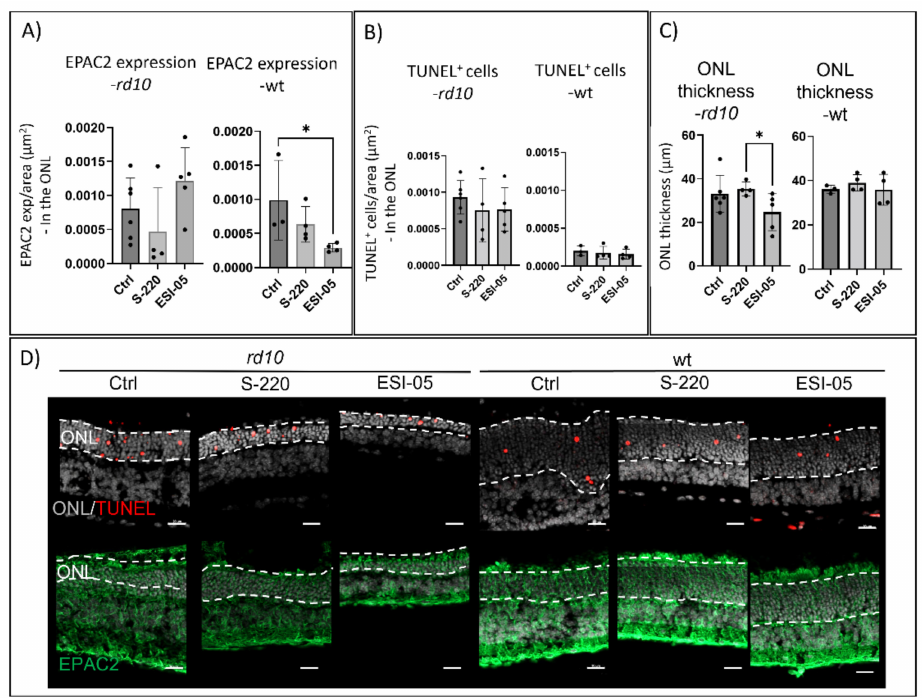
Figure 6. Inhibition of EPAC2 activity decreases ONL thickness in the rd10 model. ( A ) Inhibition of EPAC2 activity by ESI-05 in rd10 explants (treatment paradigm: PN12-PN24) caused a numerical but not significant increase in EPAC2 expression compared to the control (Ctrl, i.e., untreated retina) and the S-220-treated retina. For the wt retina, the activator S-220 reduced EPAC2 expression significantly in the ONL compared to Ctrl. ( B ) The rd10 explants had significantly more TUNEL-positive cells compared to their healthy counterparts. No differences in the number of TUNEL + cells was associated with the treatments. ( C ) ESI-05 treatment leads to a significant reduction in ONL thickness in rd10 explants but not in wt explants. ( D ) Examples of stainings, forming the basis of the graphs above. All figures represent mean ± SD. Results represent three to six biological replicates. The Kruskal–Wallis statistical method was applied to identify statistical significance (* p < 0.05). The dotted line in figure C marks the ONL (outer nuclear layer). Scale bar = 20 µ